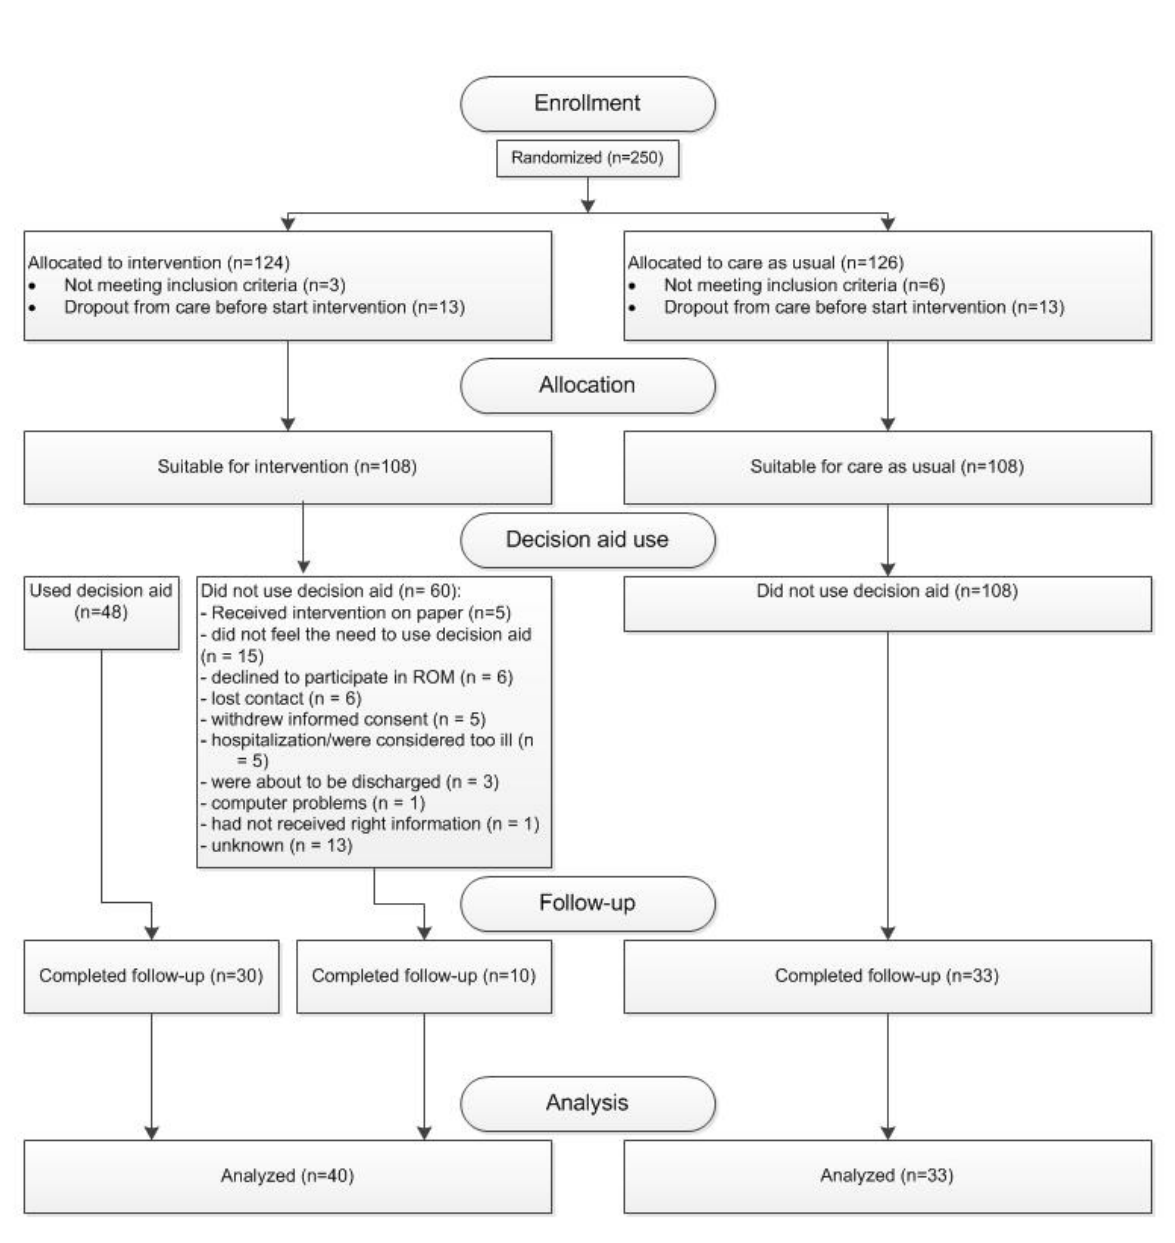
Figure 4. Participant flow